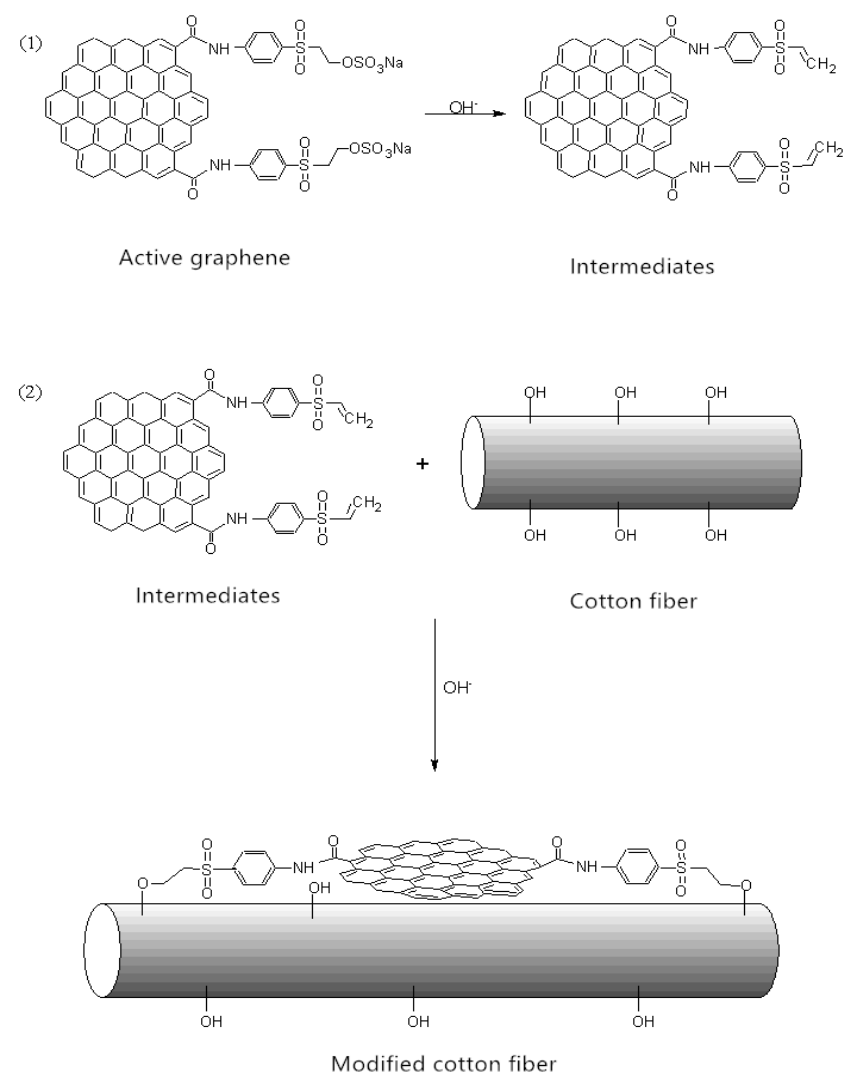
Figure 3. The reaction process of modified cotton fiber.